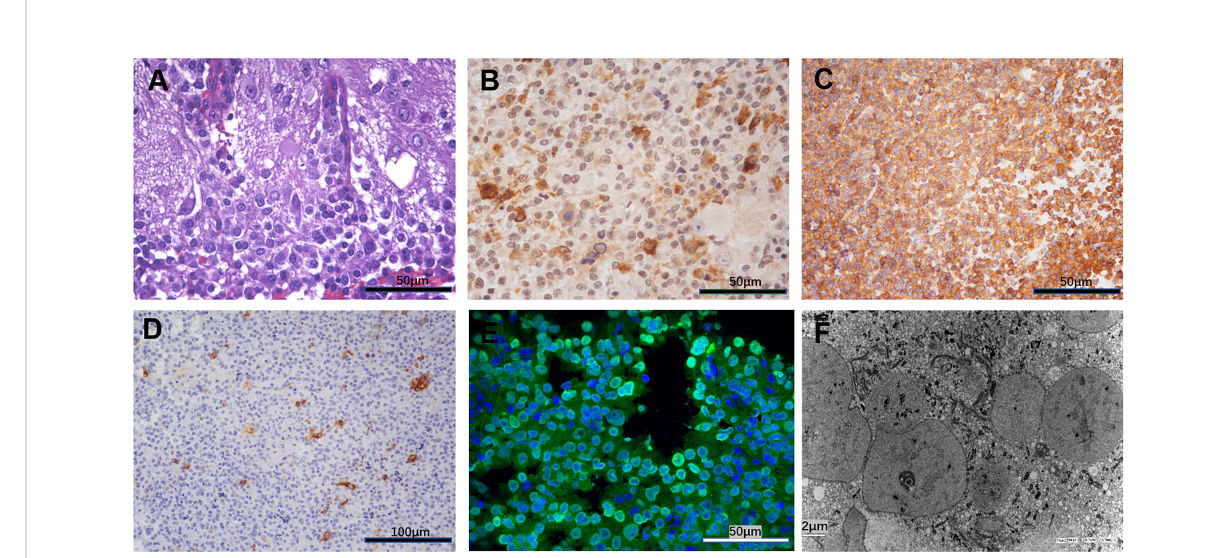
FIGURE 2 (A) Hematoxylin-eosin HE revealed cap-like gangliocytoma cells surrounding the adenoma cells. (B) Immunohistochemistry showed strongly positive for growth hormone. (C) Immunohistochemistry showed strongly positive for synapsin. (D) Immunohistochemistry showed scattered positive for Prolactin (PRL). (E) Immuno fl uorescent staining show strong positive for Pituitary Transcript Factor 1(Pit-1). (F) The ultrastructure observed by Electron